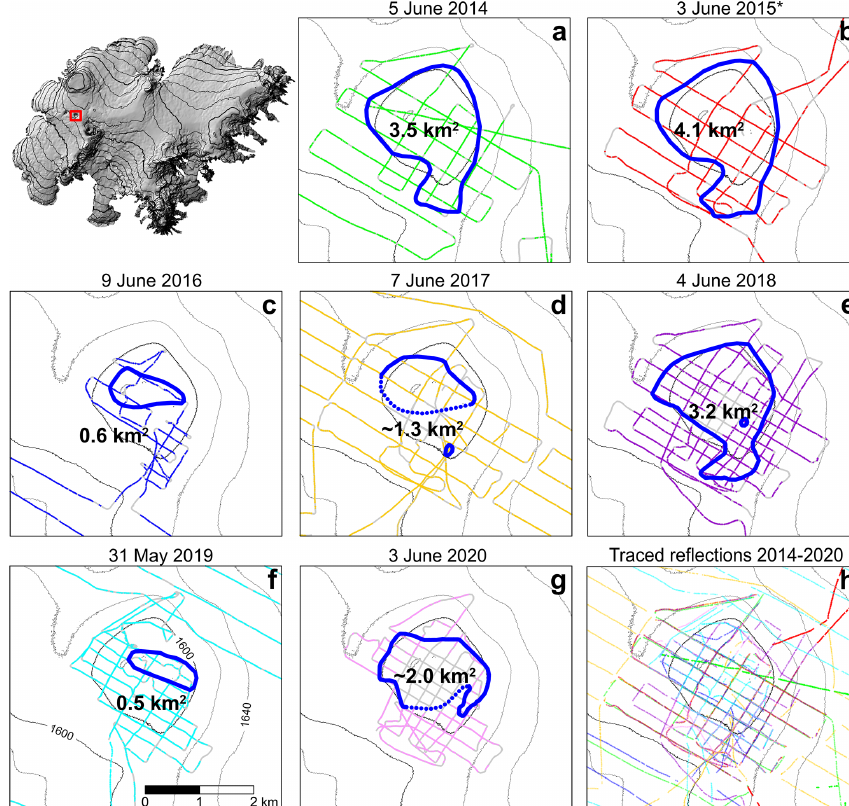
Figure 4. (a–g) Traced bed reflections (both ice–water and ice–bedrock reflections) for the RES surveys in 2014–2020. Locations of traced reflections of each survey are displayed in different colours on top of the survey route of each year (shown as grey lines). The contour map shows the surface elevation in September 2015 (TanDEM-X). Polygons (blue line) and numbers indicate derived margin and area of the subglacial lake for the corresponding year. Poorly constrained sections of the lake margin are shown with a dotted line. Locations of all traced reflections with corresponding colour-coding are shown in panel (h) . ∗ Note that in panel (b) one profile, surveyed by driving from the cauldron’s centre out of the study area towards northeast, was acquired in February 2015. It was only used to approximate the position of the lake margin in spring 2014 and 2015 and for tracing the bedrock reflection outside the